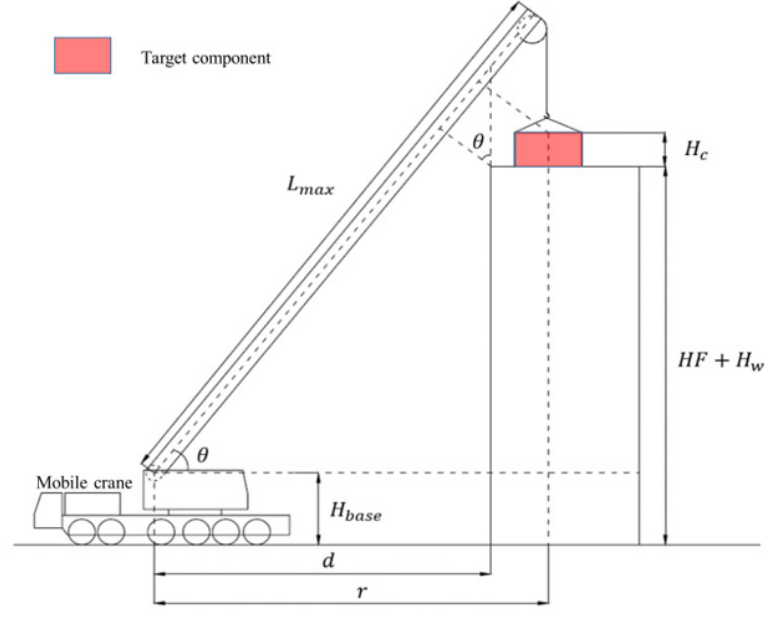
Figure 5. Safety constraint check.